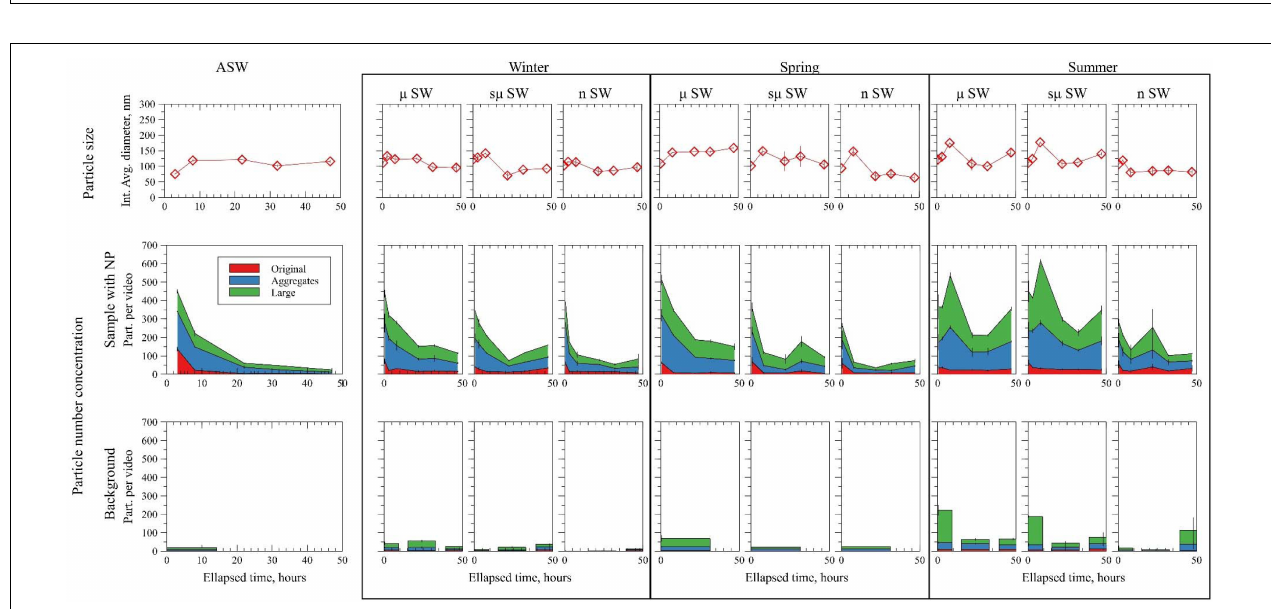
FIGURE 3 | Areas selected for estimating the concentration of particles from NTA measurements according to size and intensity. The inner red ellipse corresponds to “original” particles; the outer purple ellipse corresponds to “aggregates” particles, as described in the text. The contour plots correspond to the following samples, discriminated by size and intensity: (A) the average of all particles measured in the experiments (154 samples), (B) one replicate from the AuNP spiked in milli-Q water (number of particles tracked scaled by 10 to facilitate comparison), (C) one replicate of the summer sample µ SW (background signal) and (D) one replicate for the spiked summer sample µ SW taken at time 0.